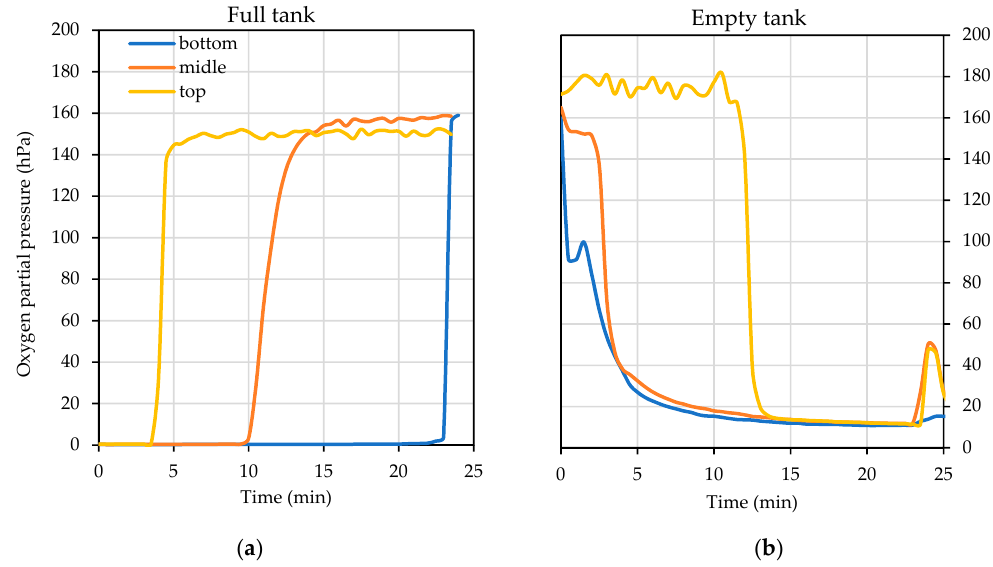
Figure 6. Evolution of the dissolved oxygen level at different points in the tanks that are emptied (full tank, ( a )) and filled (empty tank, ( b )) during a transfer with both connections at the bottom of the tanks.